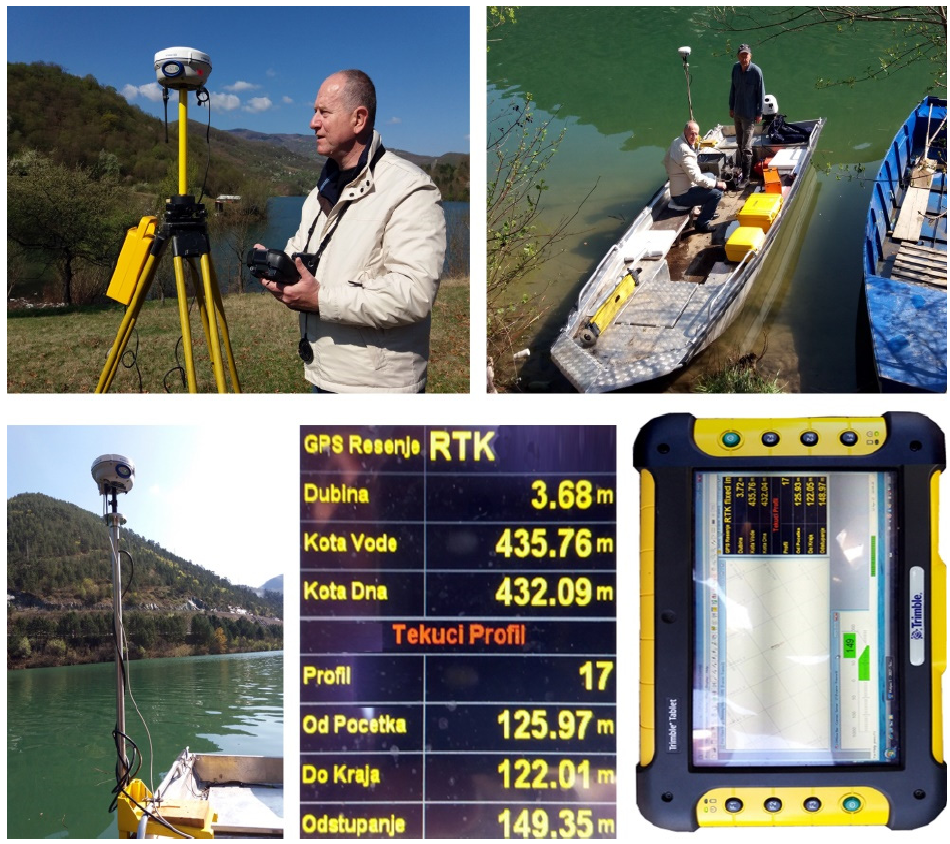
Figure 17. Bathymetric survey of the Potpec reservoir and detail of the equipment used.